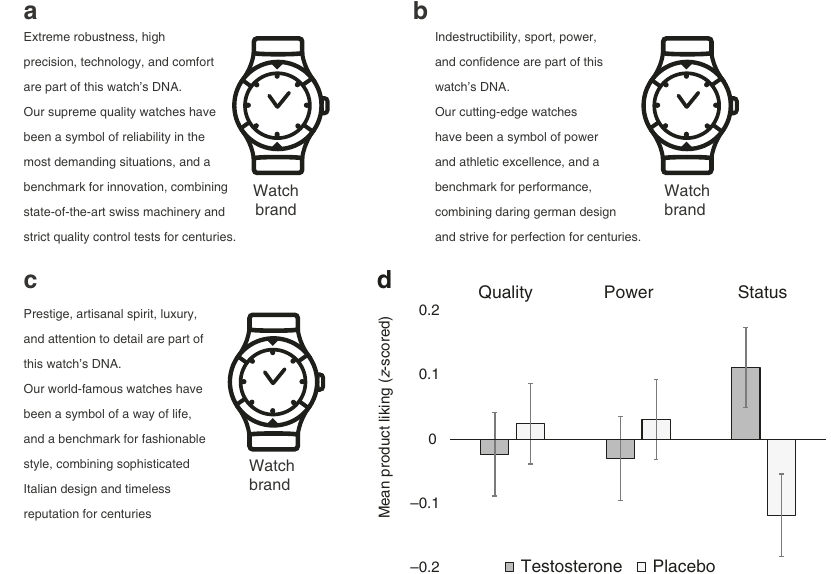
Fig. 3 Task measuring attitudes towards identical goods associated with different rank-enhancing strategies and results. For each of six goods we created three different text ads emphasizing either its associations with ( a ) high quality, ( b) power, or ( c) status. The ads were identical otherwise. d Mean attitudes of the goods ( N = 243 participants) for each of the three conditions ( z -scored at the ad level). Error bars denote s.e.m. For the corresponding dot plot, see Supplementary Fig. 3. The watch clipart was created by Professor Amos